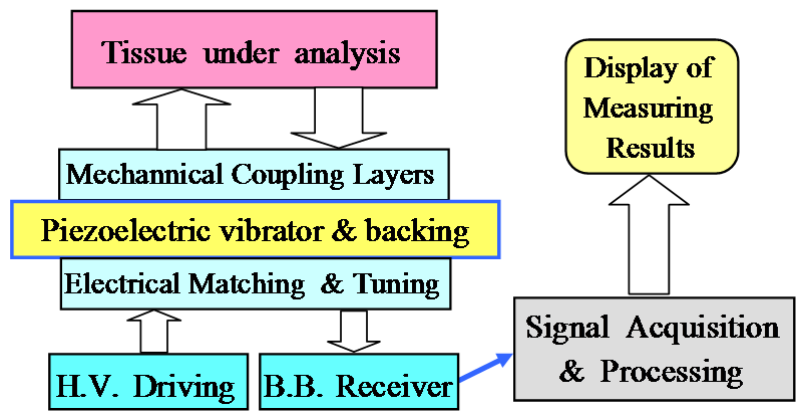
Figure 2. Blocks of a monochannel measurement ultrasonic system using piezoelectric